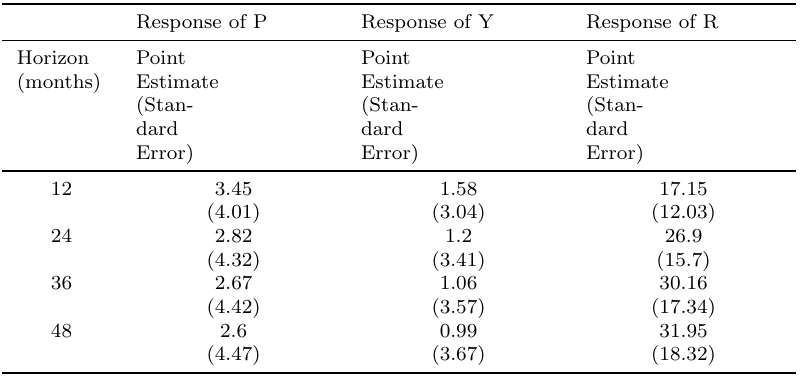
Table 4: VDCs of P, Y and R with ordering D, Y, P, R, M2, T Response of